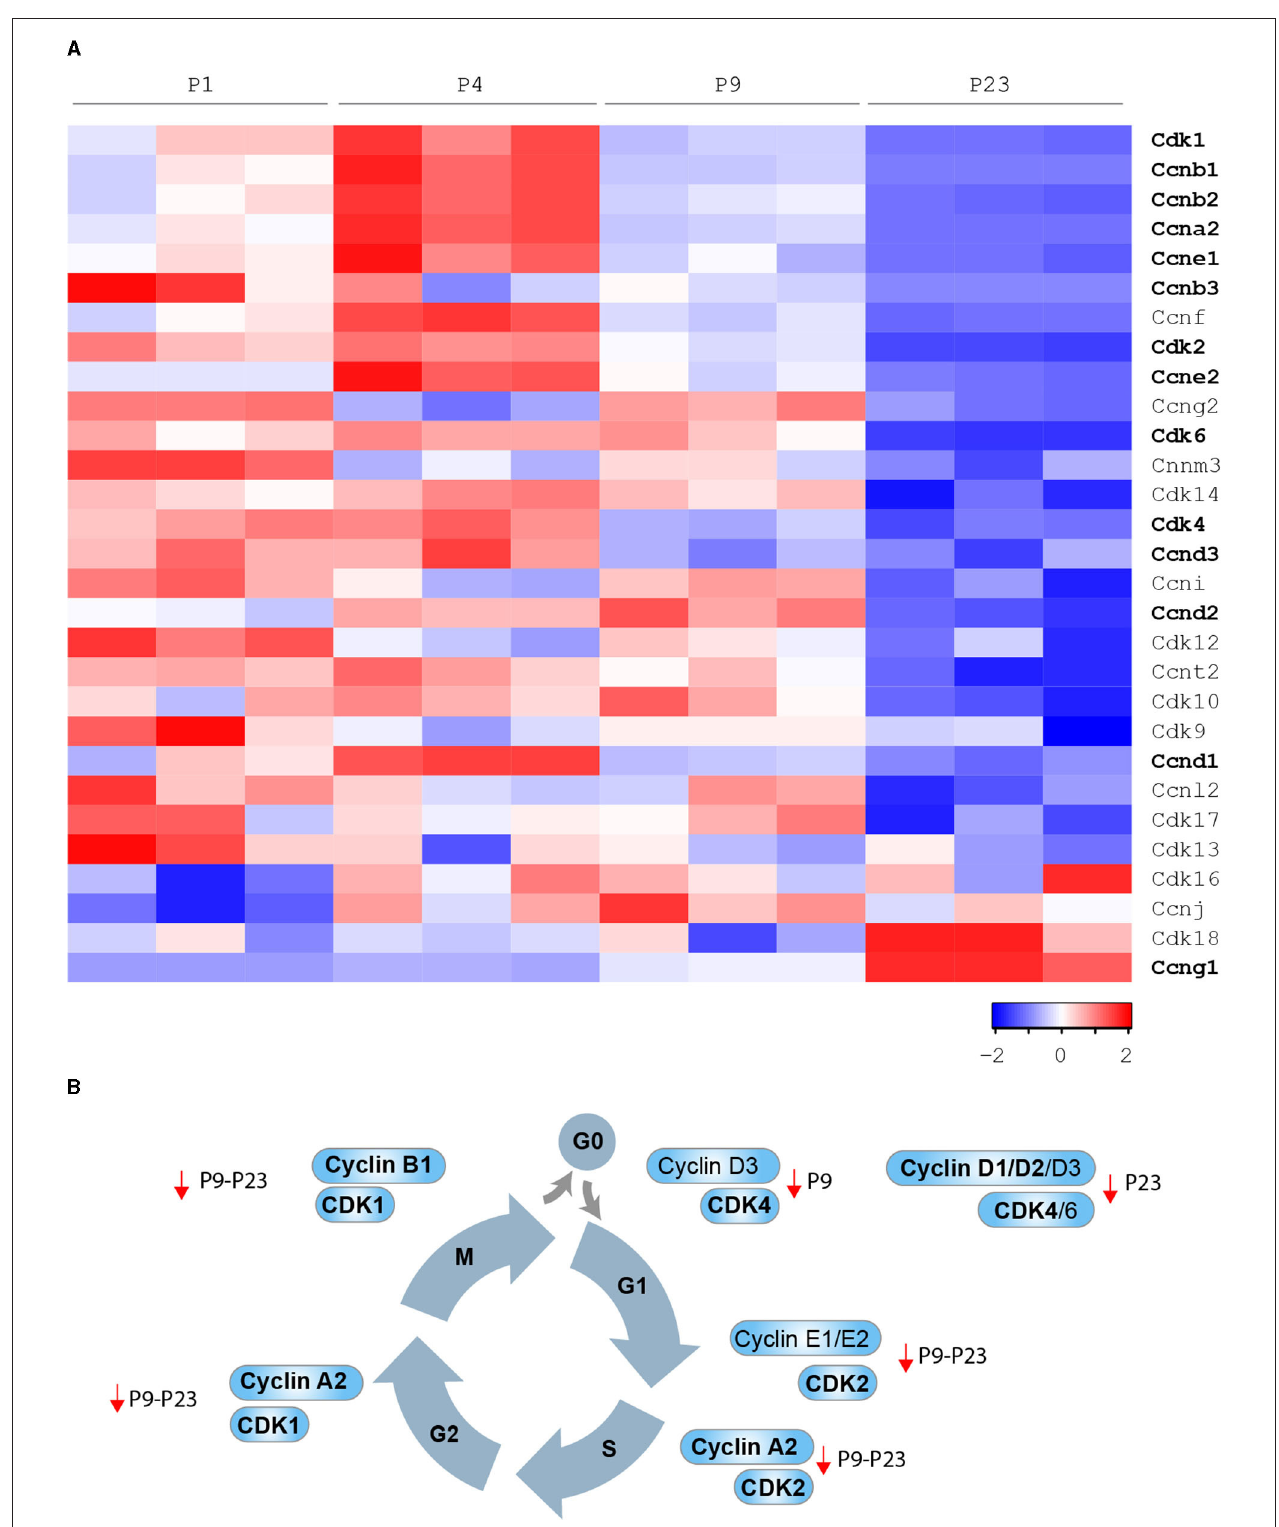
FIGURE 3 | Developmental regulation of cardiomyocyte cell cycle in mammals. (A) Cyclins and Cdks expression levels by bioinformatic analysis of the gene expression profile of the mouse heart at different developmental stages [P1, P4, P9, and P23 from Talman et al. (39)]; (B) Cyclins and CDKs whose modulation has been demonstrated to be sufficient to induce postnatal cardiomyocyte cell cycle progression (in bold cell cycle factors that were reported to induce adult cardiomyocyte regeneration after major injuries).